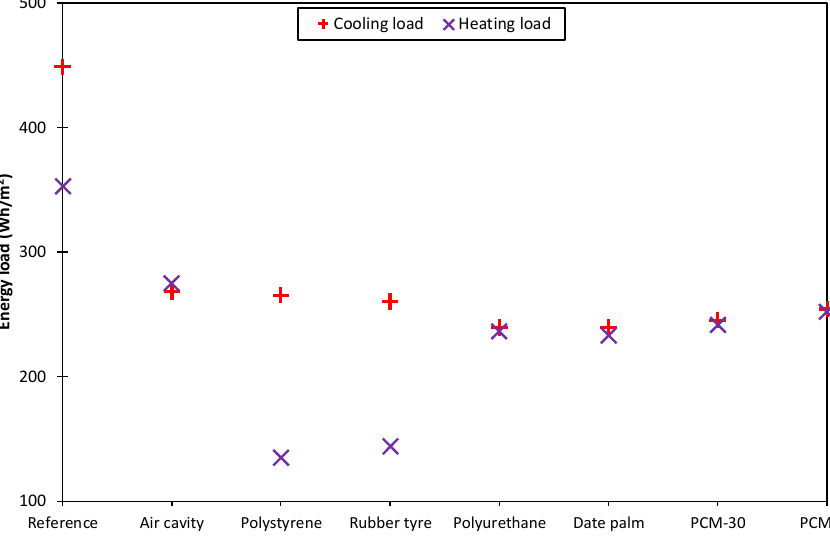
Figure 7. Heating/cooling load reduction using different insulations as compared to the reference in hot and cold climatic conditions.